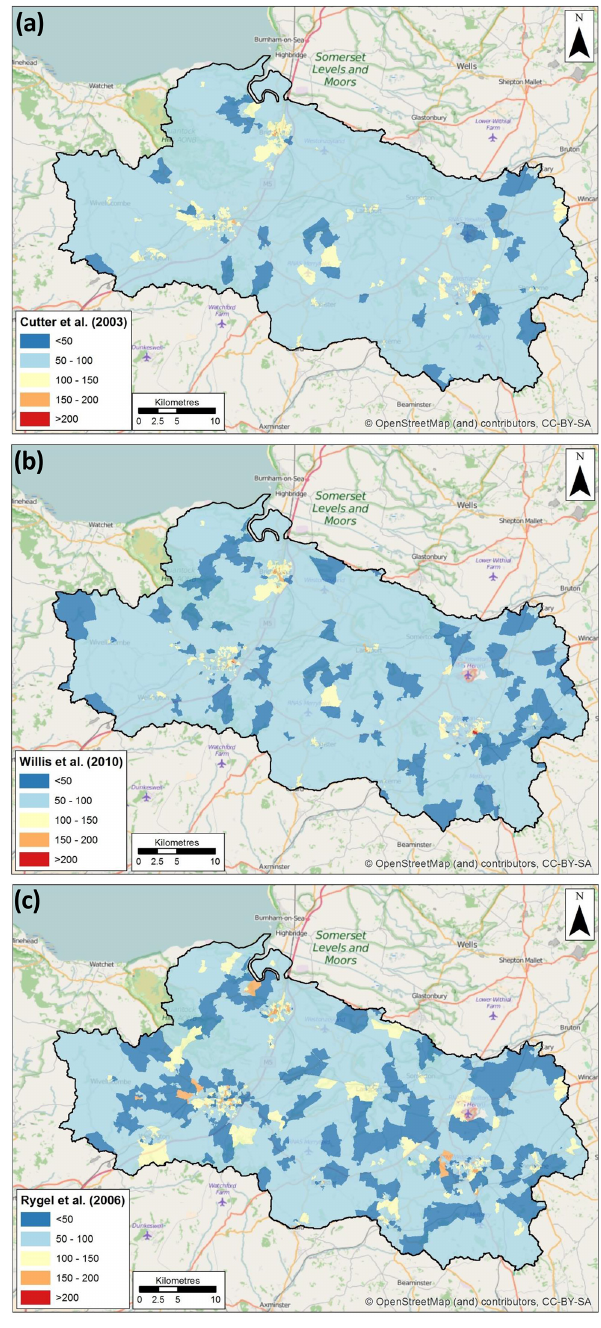
Figure 6. (a) Spatial analysis of social vulnerability index based on the Cutter et al. (2003) methodology for the Parrett catchment, UK. (b) Spatial analysis of social vulnerability index based on the Willis et al. (2010) methodology for the Parrett catchment, UK. (c) Spatial analysis of social vulnerability index based on the Rygel et al. (2006) methodology for the Parrett catchment,